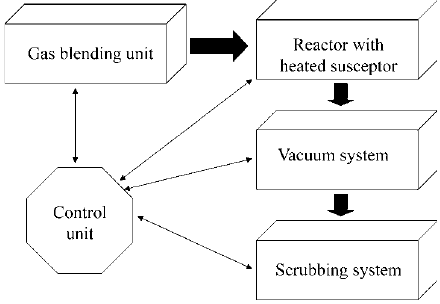
FIGURE 1 Components of a low pressure MOCVD